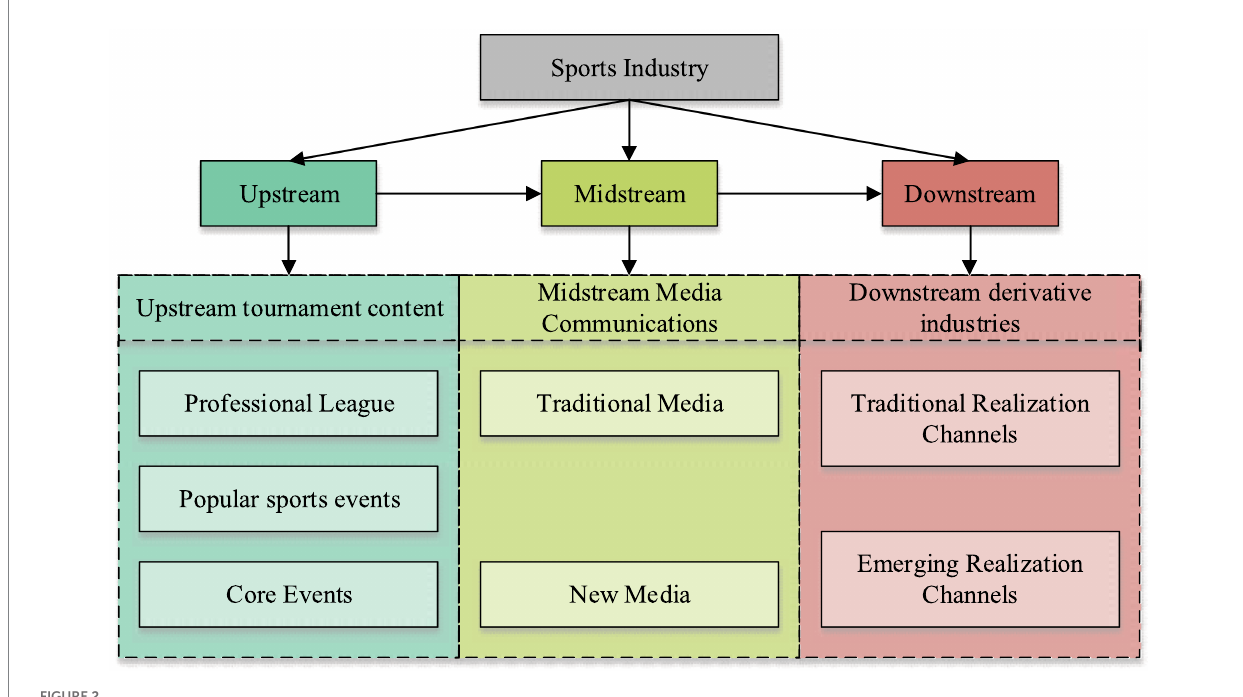
FIGURE 2 Industrial chain structure of the sports